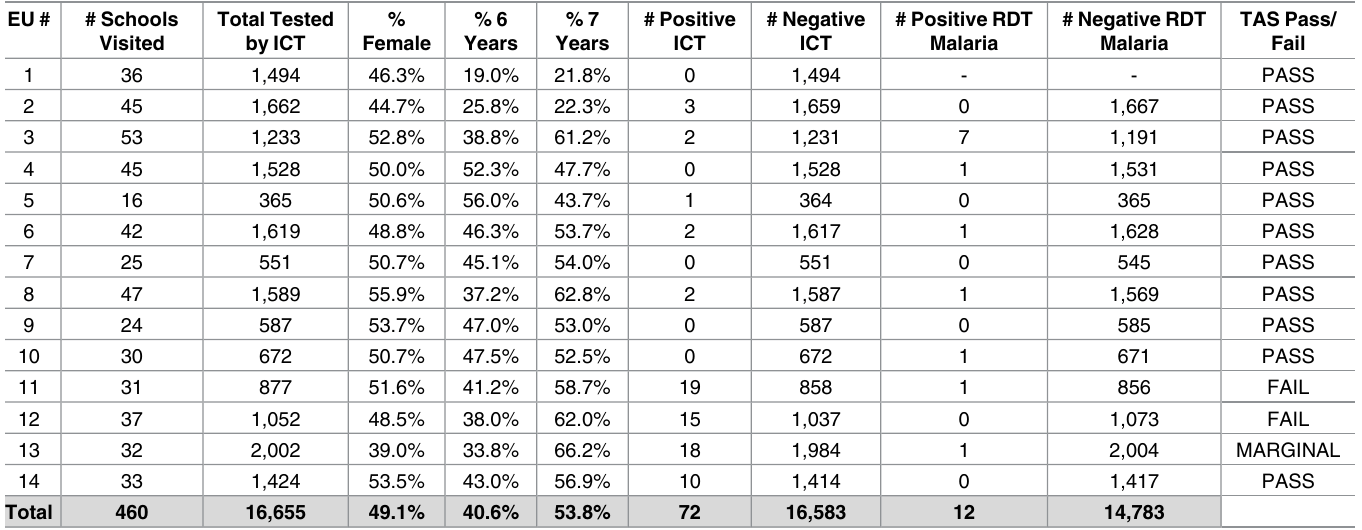
Table 3. Results: Transmission Assessment